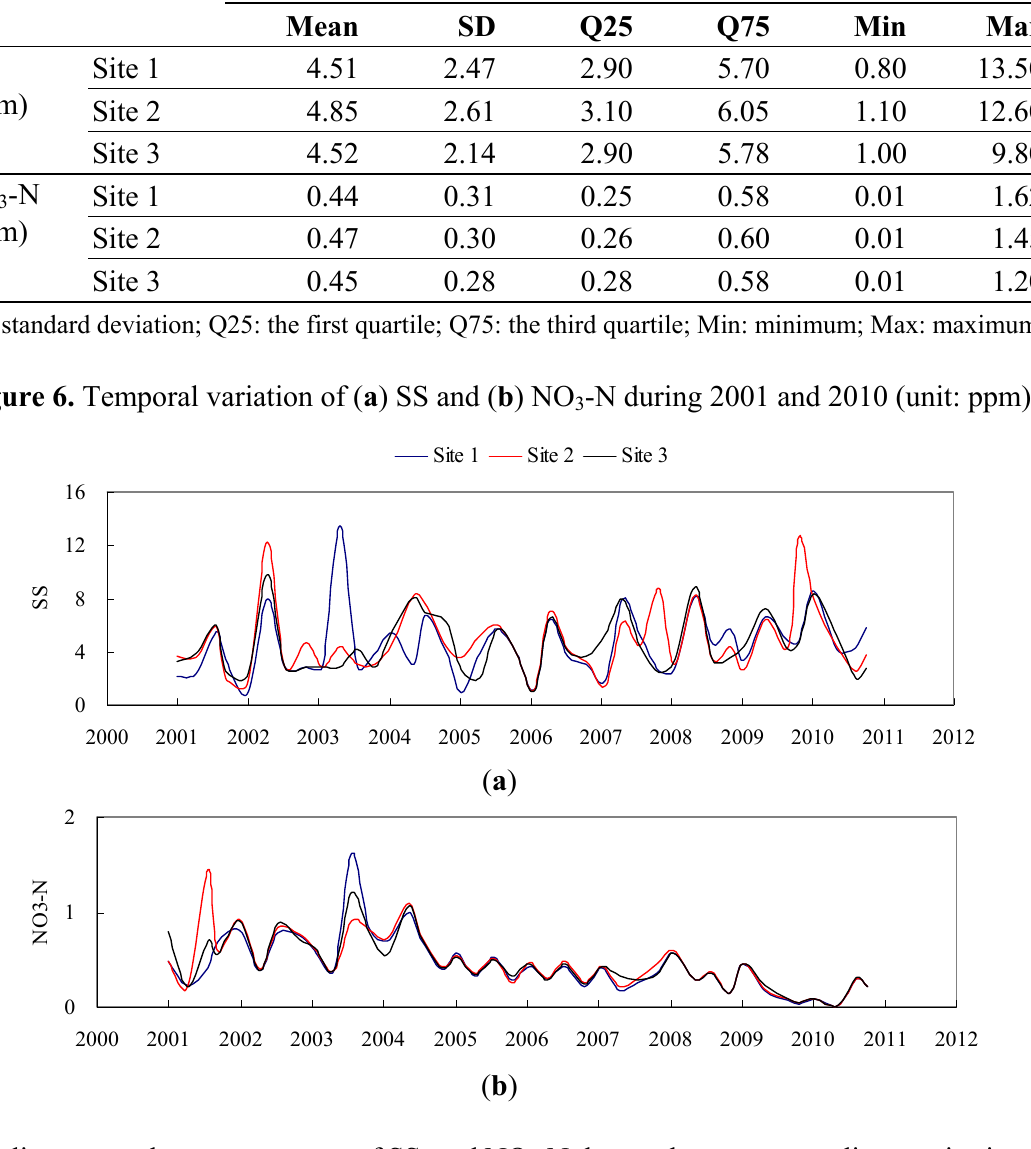
-N data in three water quality-monitoring 3